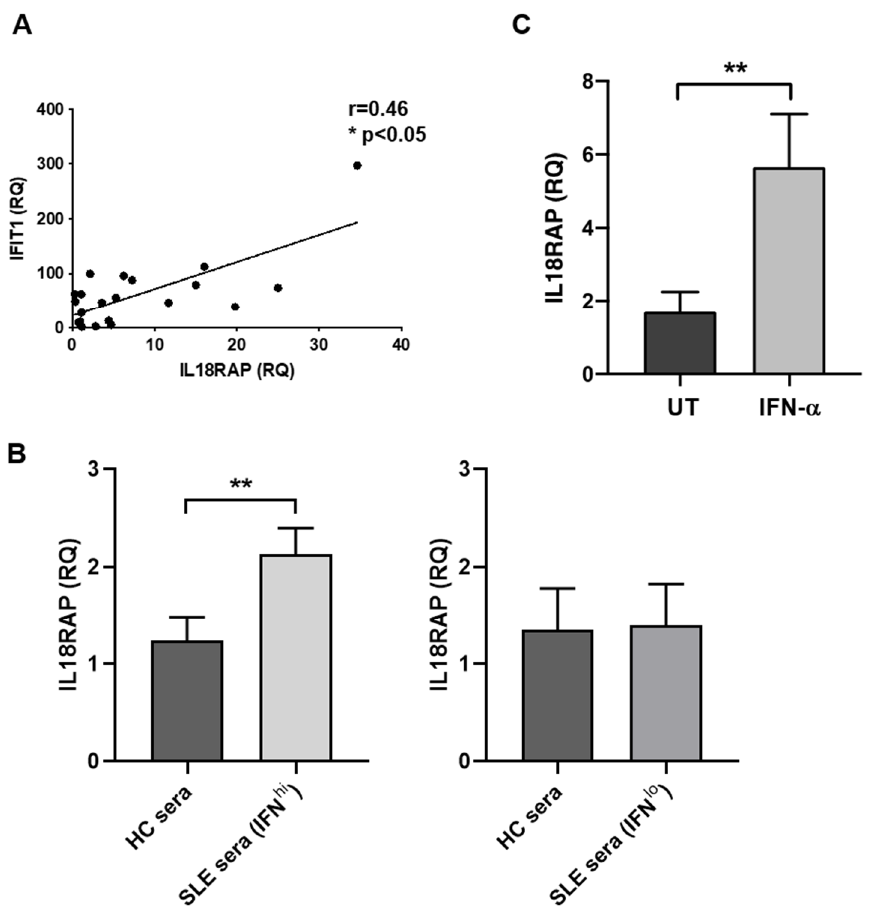
Figure 3. Regulation of IL18RAP expression by type I interferon (IFN) in neutrophils. ( A ) Expression correlation between IL18RAP and IFIT1 in neutrophils of SLE patients ( n = 21). Linear regression line is shown; r = correlation coefficient; * p < 0.05 by Spearman’s rank-order test. ( B ) IL18RAP expression in healthy neutrophils upon culture with sera from HC and SLE patients was evaluated. Samples from healthy individuals ( n = 12) were treated with HC sera and SLE sera with high IFN activity (IFN hi ) (left panel). Six individuals ( n = 6) were treated with HC sera and SLE sera with low IFN activity (IFN lo ) (right panel). A paired t test was used to compare data from the same samples treated with HC sera and SLE sera. ( C ) IL18RAP expression in healthy neutrophils ( n = 8) was compared between those cultured in medium alone (untreated group, UT) and those cultured in the presence of recombinant human IFN- α (1000 IU/mL for 6 h). ** p < 0.01 by paired t test. RQ, relative quantity. Data are shown as mean + SEM.